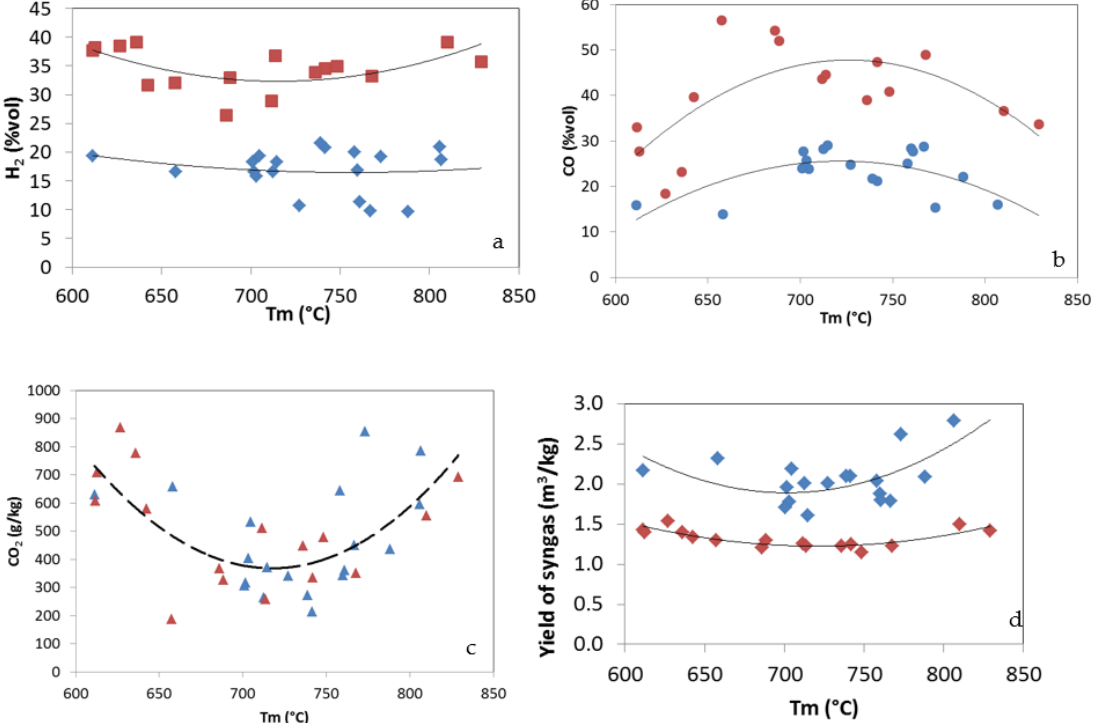
Figure 6. Content of H 2 ( a ), CO ( b ) and CO 2 ( c ) in the syngas and yield of syngas ( d ) as function of average temperature in the reactive bed. Red symbols correspond to the experimental data of the oxy-gasification; blue symbols data of the air- gasification.